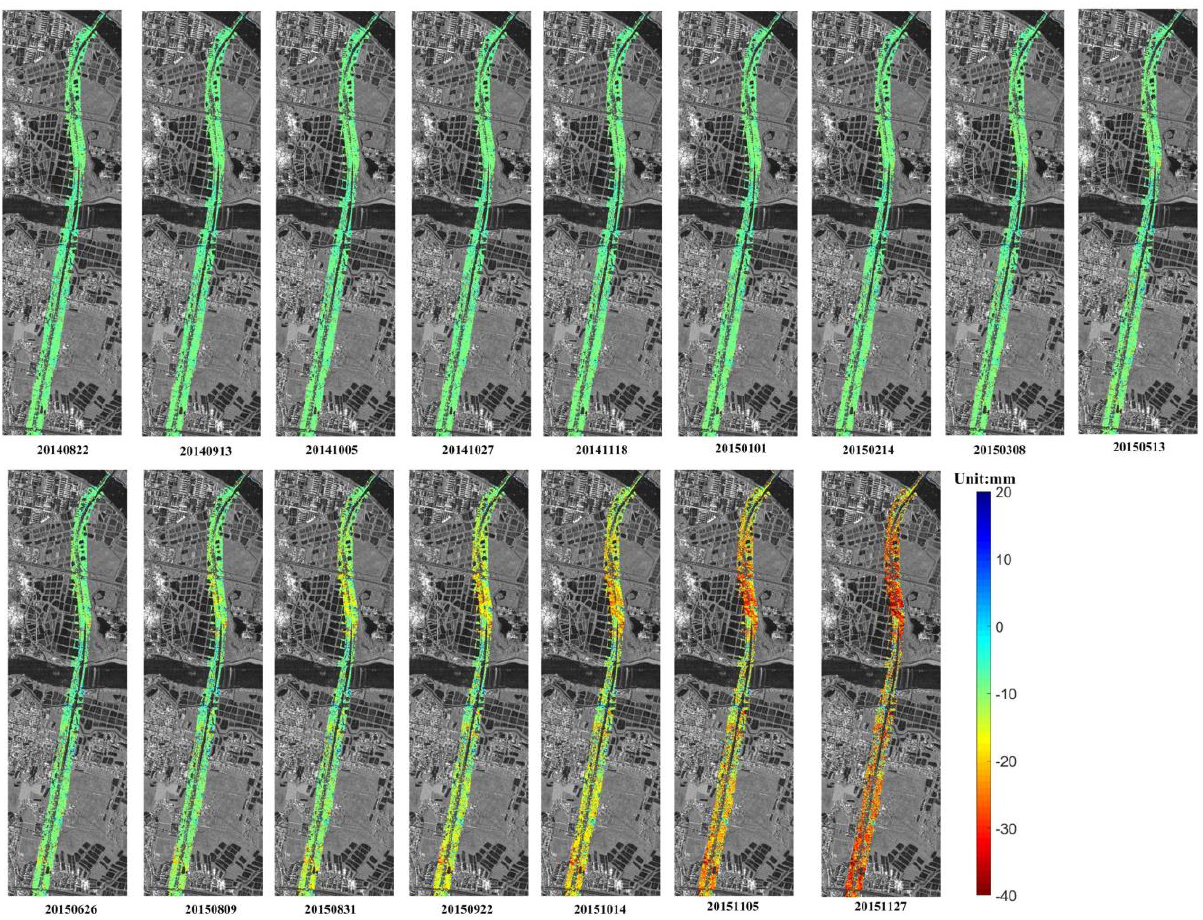
Figure 5. Time series low-pass deformation (LOS) over test highway